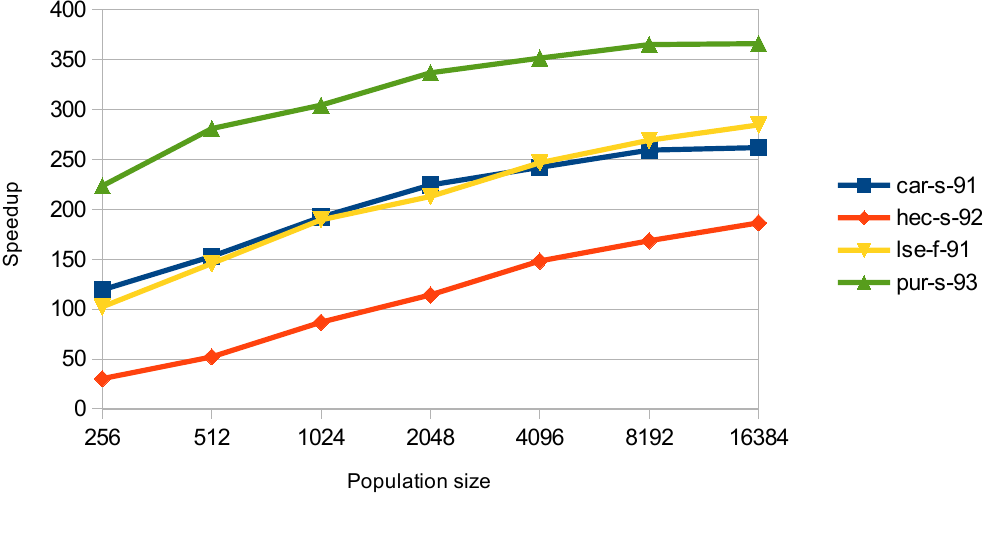
Figure 6. Speedup in the mutation stage for the examination-threaded approach.